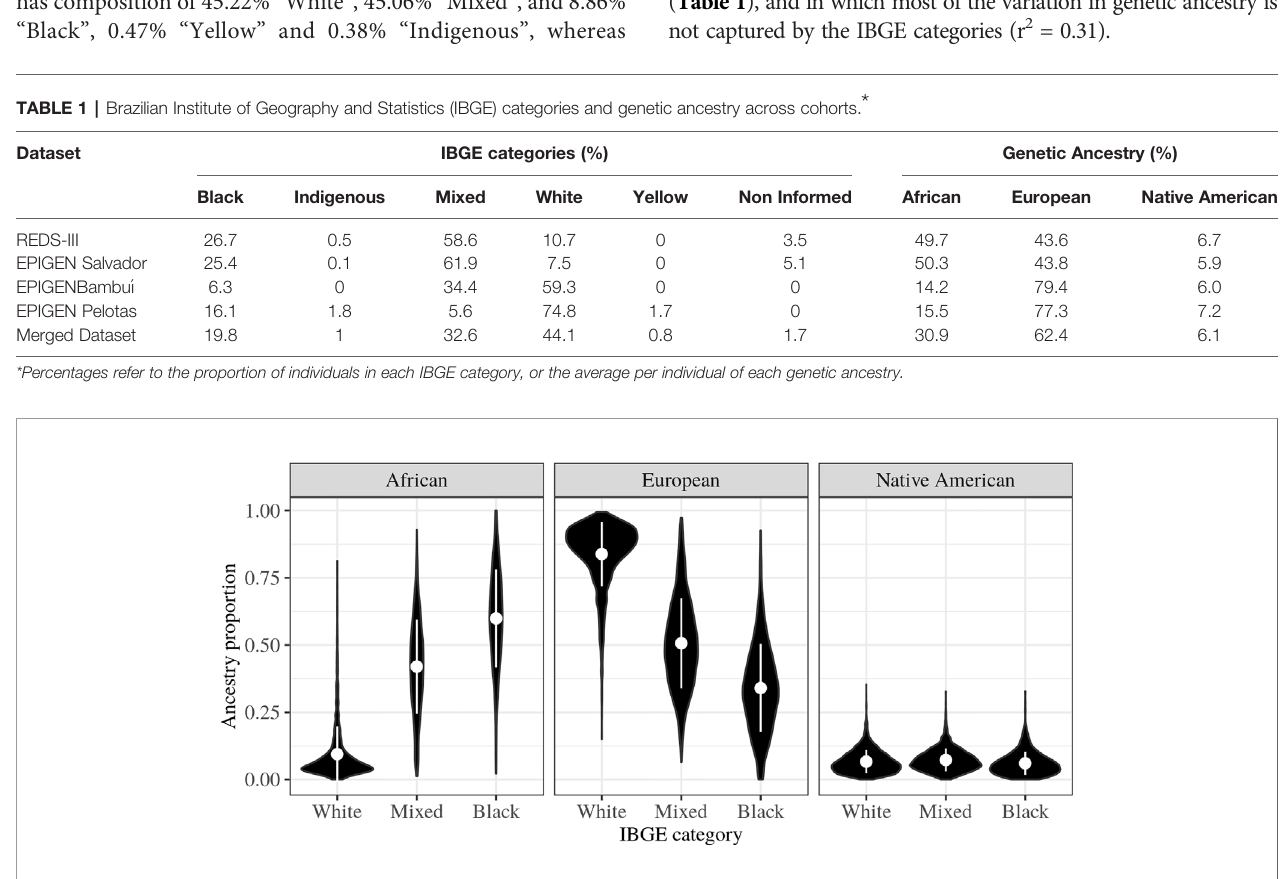
FIGURE 2 | Relationship between Brazilian Institute of Geography and Statistics (IBGE) categories ( “ Black ” , “ Mixed ” , and “ White ” ) and genetic ancestry (African, European and Native American) estimated using ADMIXTURE software in the merged dataset (REDS-III + EPIGEN). The white circles represent the averages and the vertical white lines correspond to one standard deviation, and the black shapes describe the distribution of ancestries within each IBGE